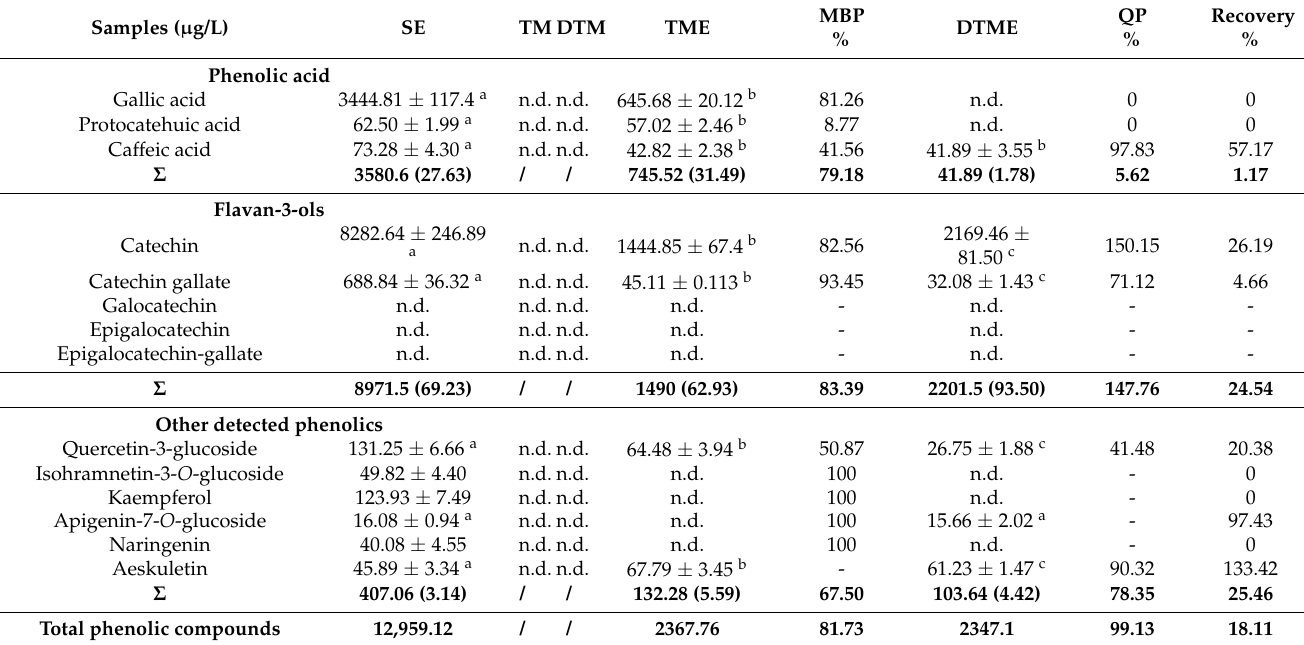
Table 2. The content and recovery of phenolics in SE, TM, and TME powders before and after in vitro gastrointestinal